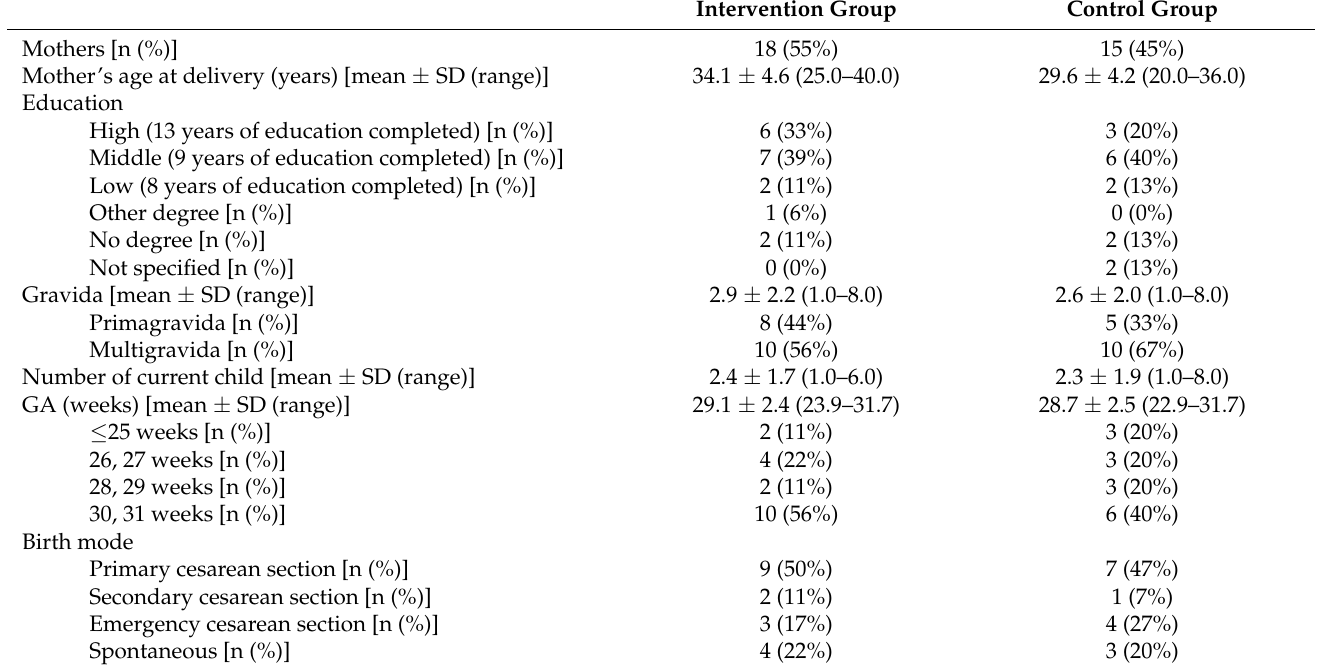
Figure 1. Flow chart of the included and excluded participants of the study. Table 1. Sociodemographic characteristics of mothers in the intervention group and the control group.